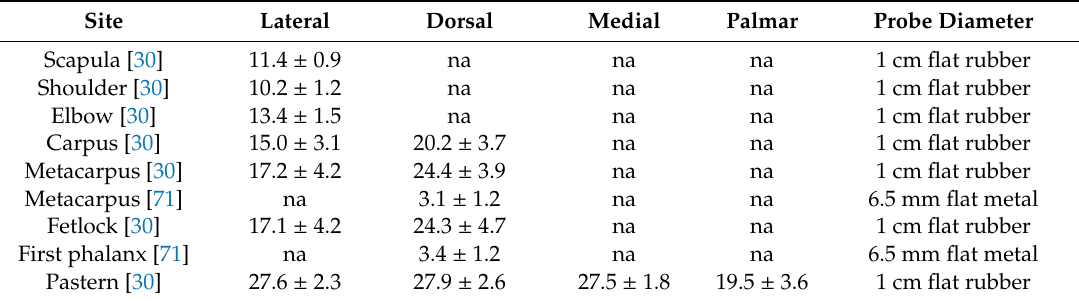
Table 10. Mean MNTs (kg / cm 2 ) measured at thoracic limb